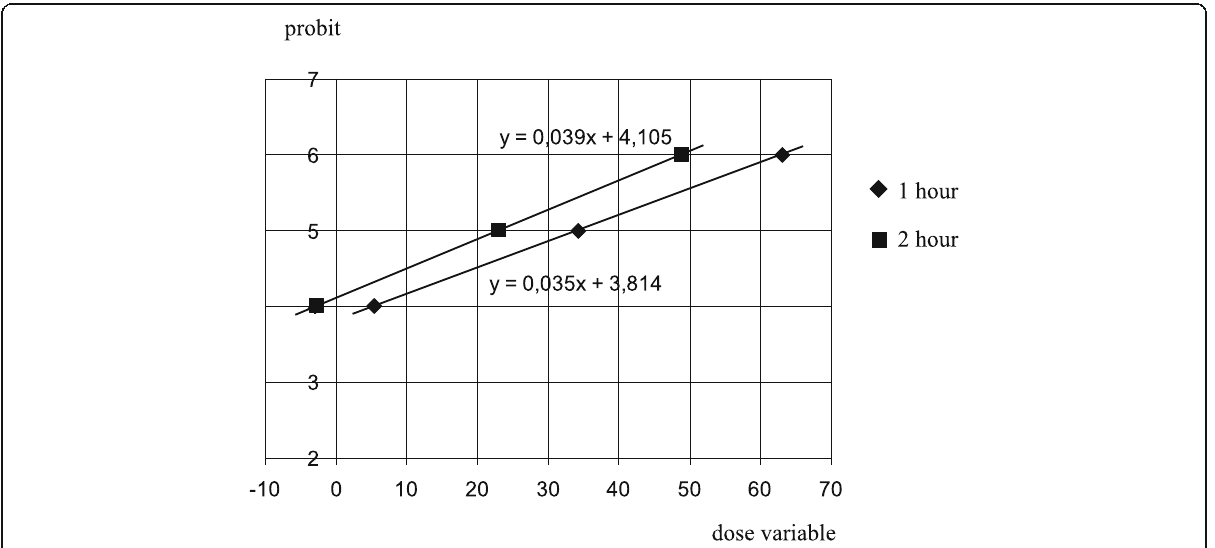
Fig. 3 Chart of Probit Analysis of the “ activity-dose ”